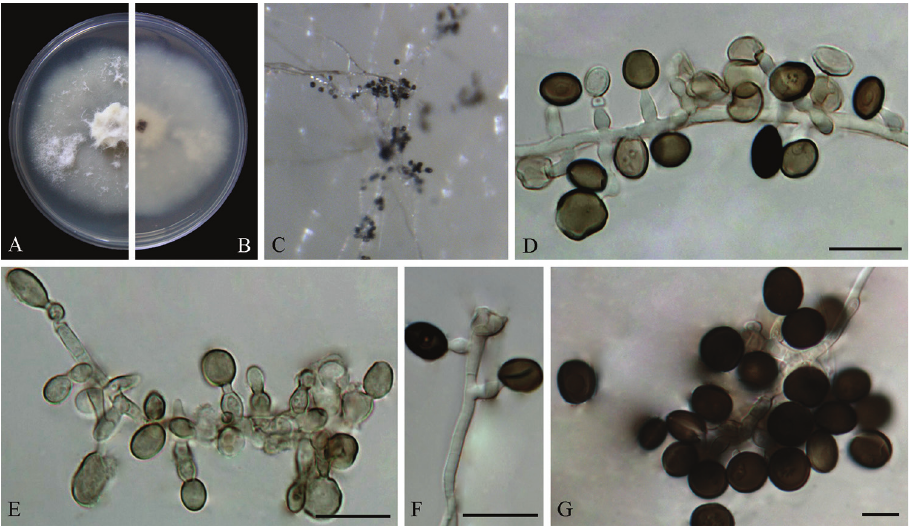
Figure 5. Arthrinium dichotomanthi (from ex-holotype strain CGMCC 3.18332) A–B 7 d old cultures on PDA C Colony on MEA producing conidia masses D–F Conidiogenous cells giving rise to conidia G Conidia. Scale bars = 10